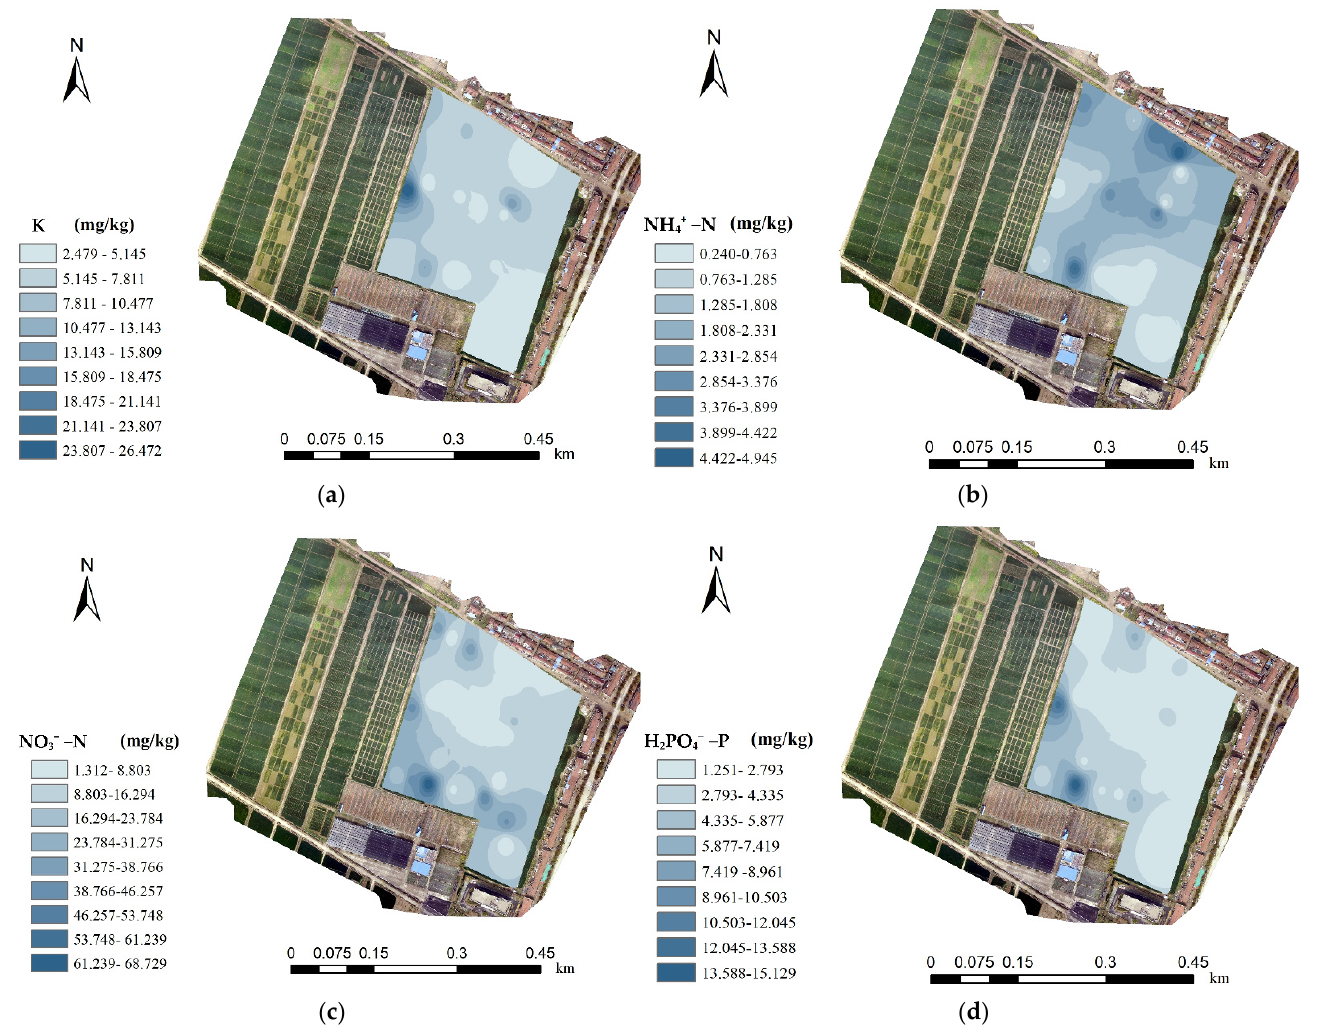
Figure 8. The content distributions of the four macronutrients: ( a ) K, ( b ) NH 4+ − N, ( c ) NO 3 − − N and ( d ) H 2 PO 4 − − P in this field. Table 2. Macronutrient contents of 24 lime concretion black soil samples (mg · kg − 1 ).